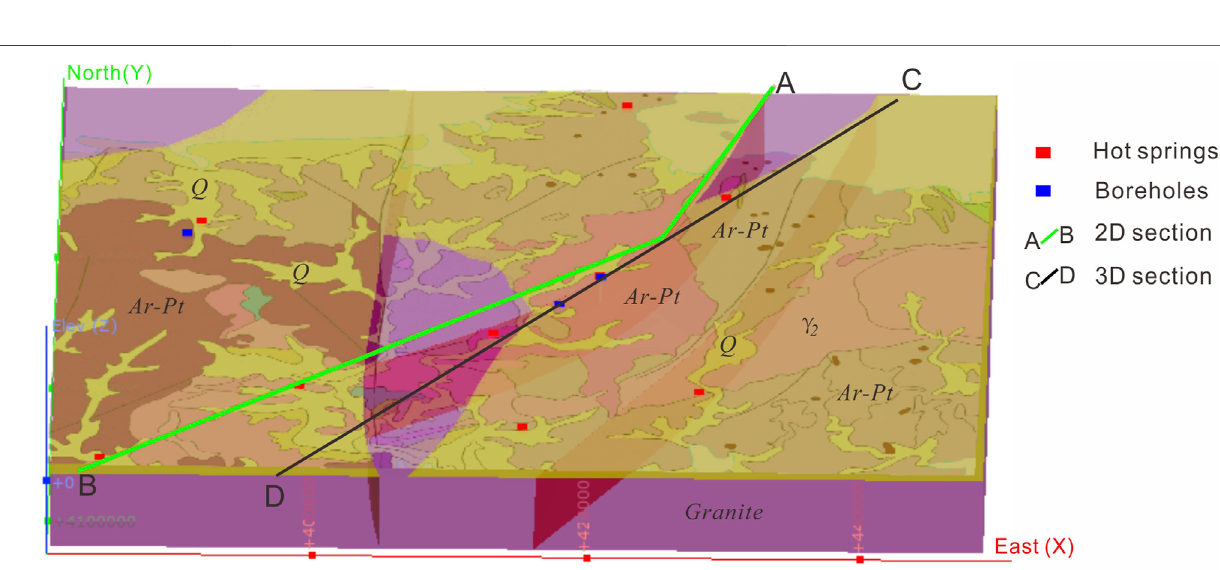
FIGURE 10 | Stratigraphic model of the Weihai uplift area (see Figure 8